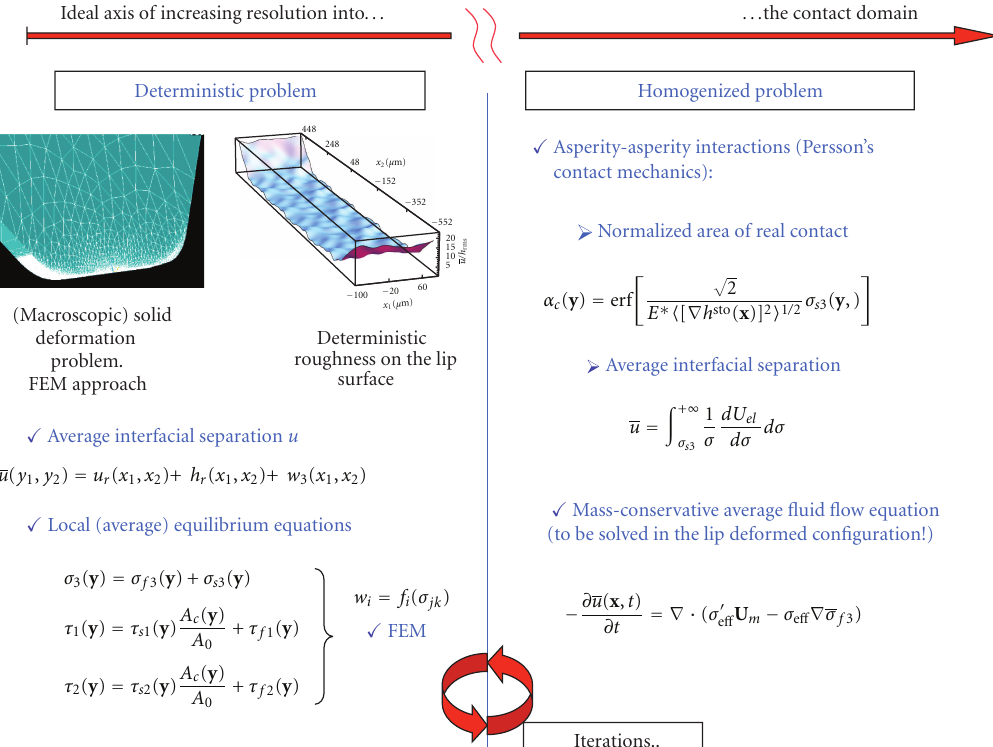
surface stress is determined by solving the homogenized part, which consists of the Persson’s contact mechanics and of the homogenized fluid problem (previously